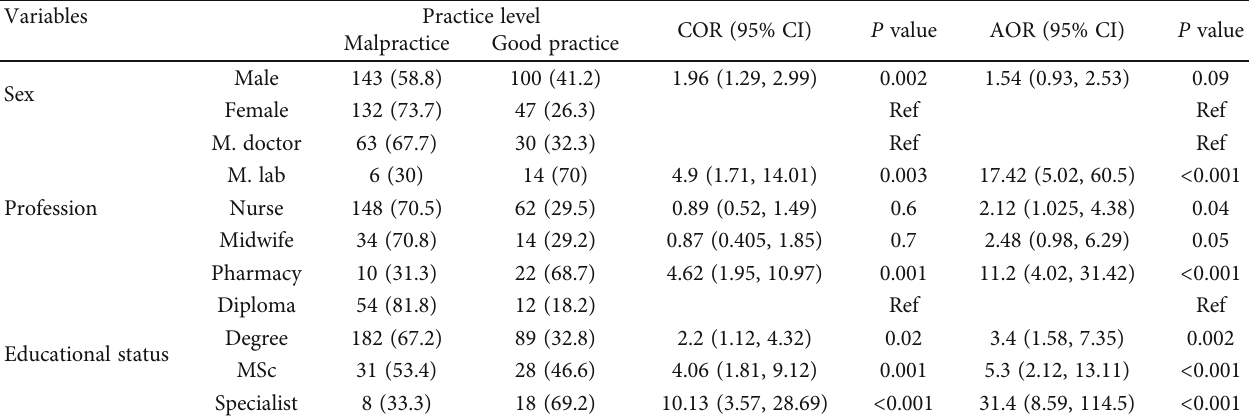
Table 10: Bivariate and multivariate analyses of associated factors of practice levels towards HBV infection. Variables